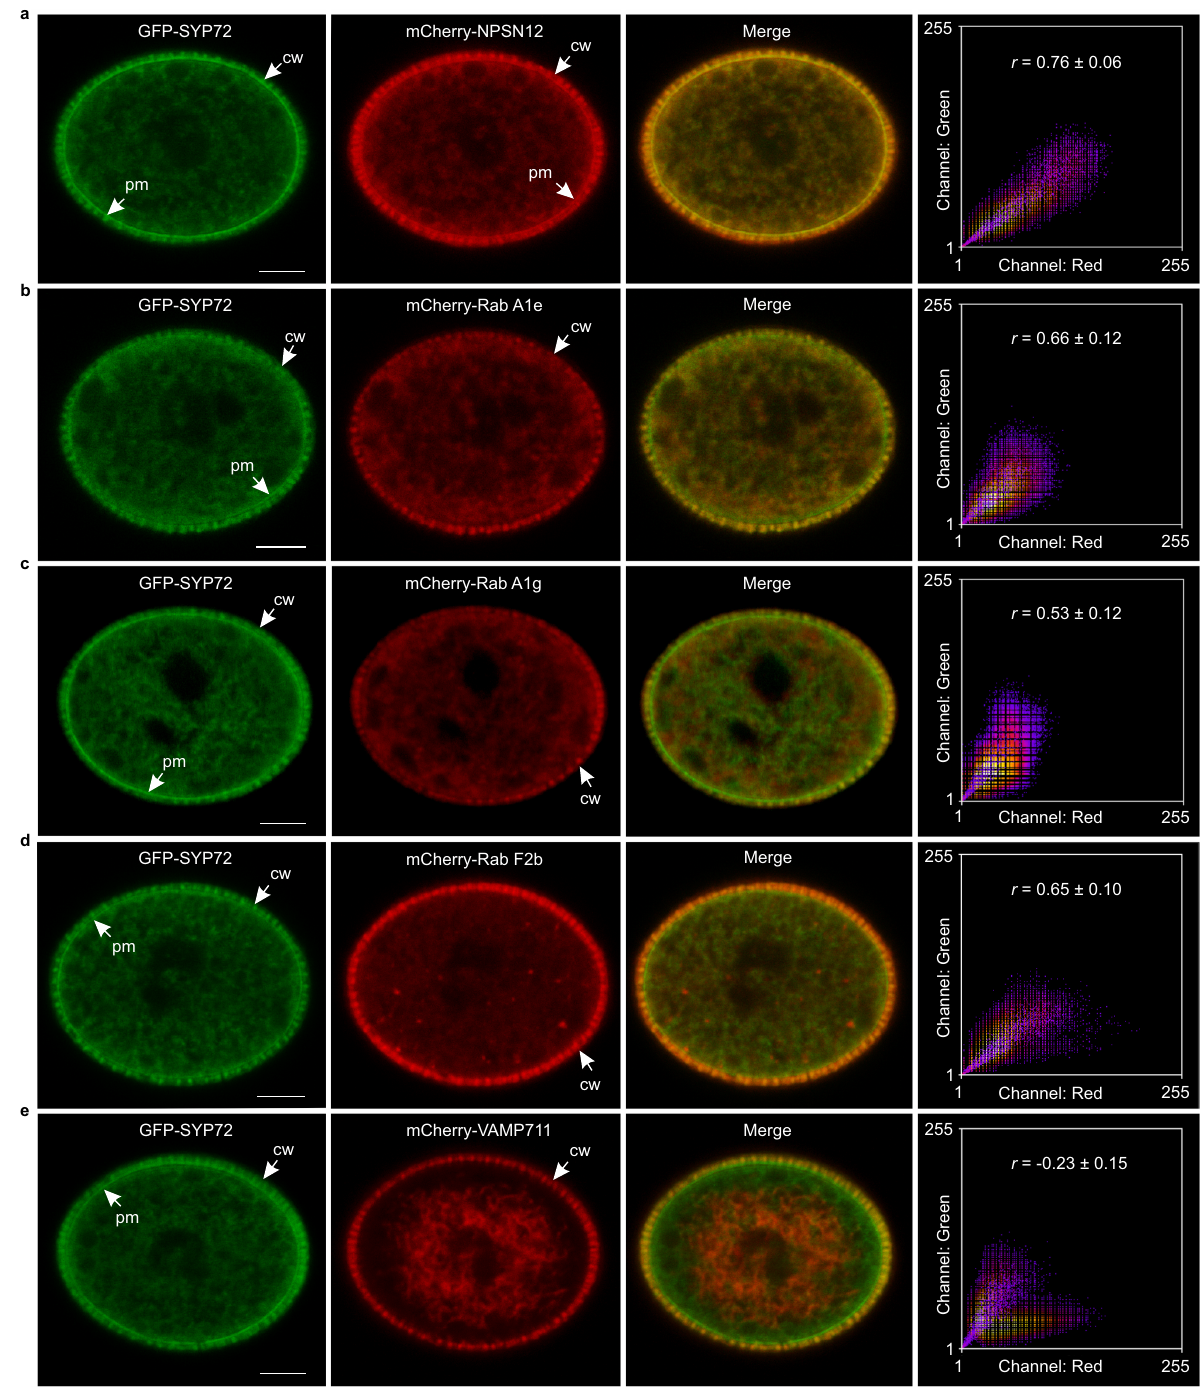
Fig. 3 Intracellular localization of SYP72 to the plasma membrane and post-Golgi endosomes in Arabidopsis pollen. a – e Representative confocal microscopic images showing the intracellular localization of GFP-SYP72 and various organellar markers in pollen grains: mCherry-NPSN12 (plasma membrane, a ), mCherry-Rab A1e (recycling endosome, b ), mCherry-Rab A1g (recycling endosome, c ), mCherry-Rab F2b (late endosome, d ), and mCherry- VAMP711 (vacuole, e ). Scale bars, 5 µ m. The rightmost column shows the scatterplots of the fl uorescence intensity of the merged images. Pearson correlation coef fi cients ( r ) indicate the extent of colocalization between GFP-SYP72 and each organellar marker. Data represent mean ± SD ( n = 15 biologically independent pollen grains for mCherry-NPSN12, mCherry-Rab A1e, mCherry-Rab A1g, and mCherry-VAMP711; n = 12 independent pollen grains for mCherry-Rab F2b). cw cell wall, pm plasma the liverwort Marchantia polymorpha , had orthologues of SYP71, lyrate rockcress ( Arabidopsis lyrata ), pink shepherd ’ s purse another member of the SYP7 subfamily (Supplementary Fig. 8a, ( Capsella rubella ), and rapeseed ( Brassica napus ), but not in other b). According to the phylogenetic tree, these SYP7 subfamily plants. However, the majority of the green lineage, including proteins clustered into six clades. In angiosperms, SYP72 and green algae, the moss Physcomitrium ( Physcomitrella ) patens , and